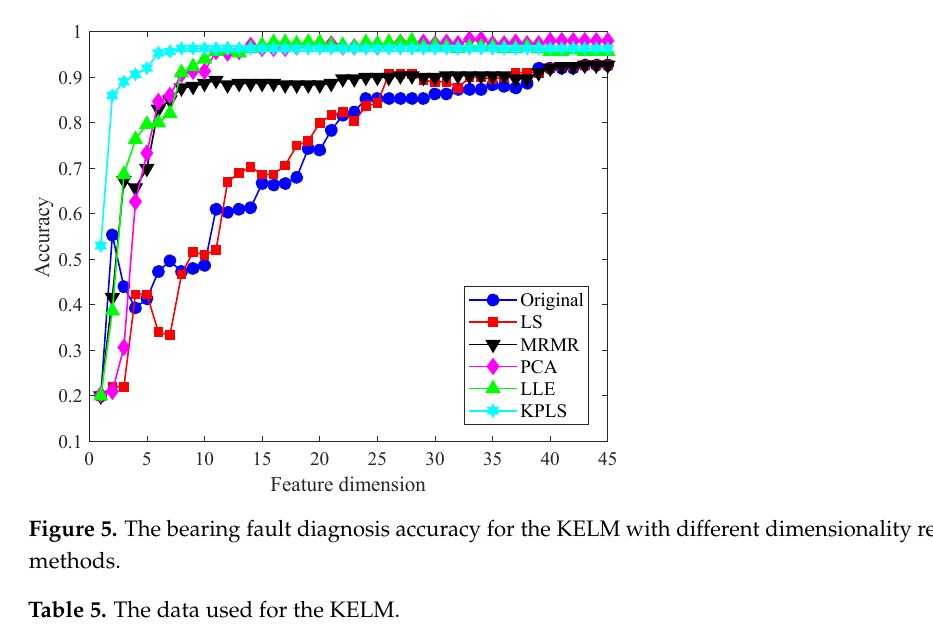
Figure 5. The bearing fault diagnosis accuracy for the KELM with different dimensionality reduction methods. Table 5. The data used for the KELM.